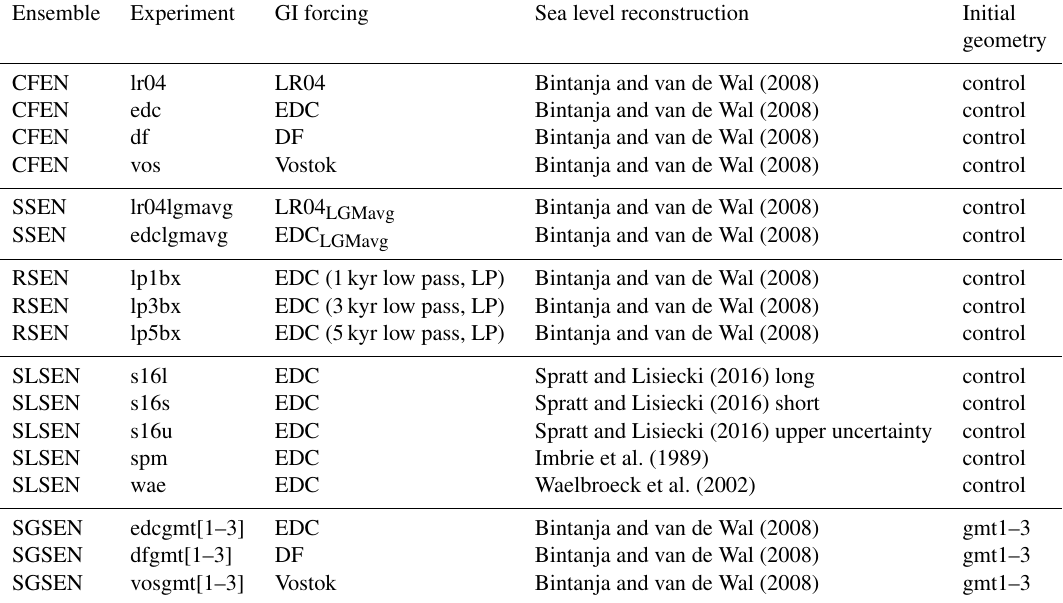
Table 3. Summary of performed experiments grouped by ensemble, listing their respective GI forcings, applied sea level reconstruction, and choice of initial geometry. LGMavg denotes that the GI was rescaled using the average LGM value as opposed to the peak value (see Sect. 2.3.1 and Table 4). The SGSEN experiments were grouped for better visualisation, but each SGSEN row corresponds to three experiments, one starting from each geometry